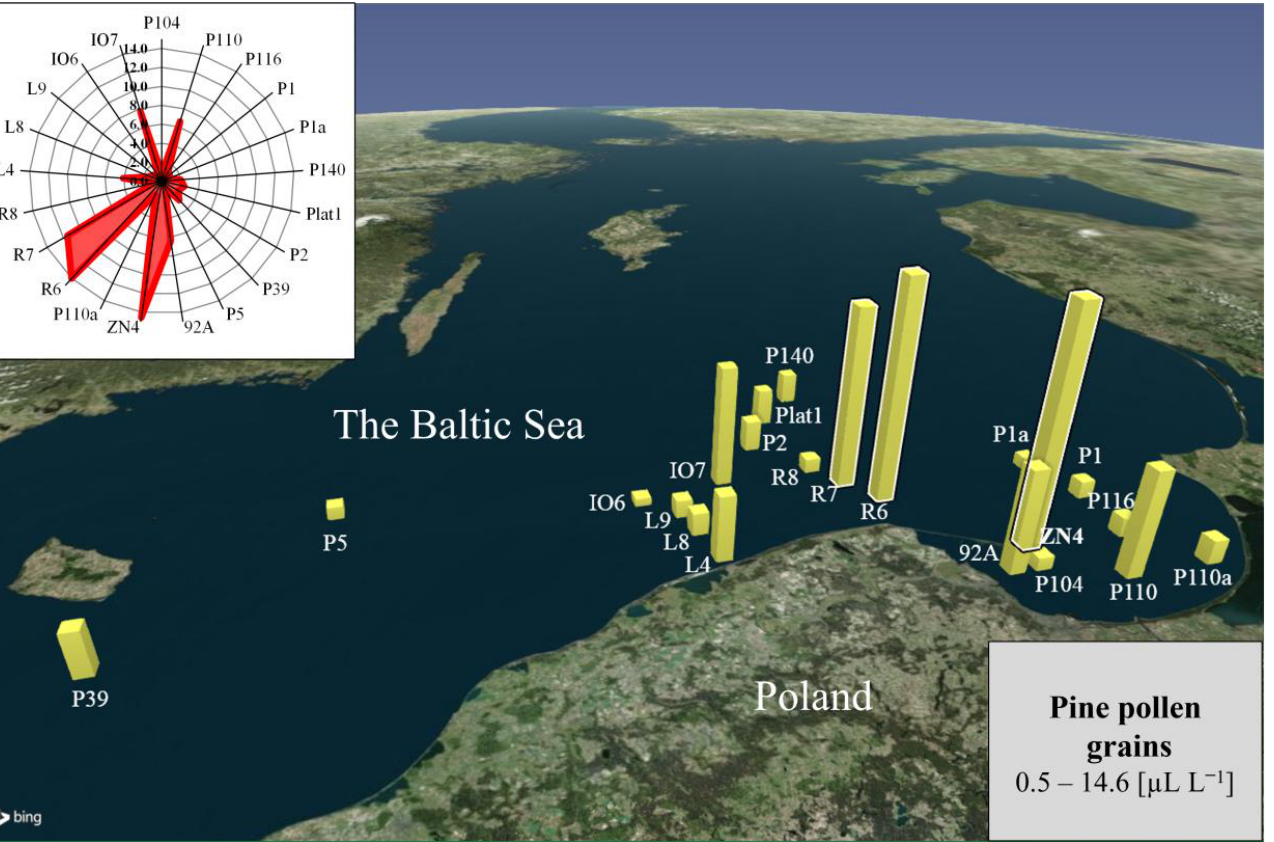
Figure 3. Spatial distribution of concentration of pine pollen grains in May 2018 in (µL L −1 ). Spatially, the pollen concentrations varied very widely: they could be very high or low even at stations quite close to each other. For example, at the open sea stations R7 and R8, ca. 10 km apart, the respective concentrations were 11.49 µ L L − 1 and 0.98 µ L L − 1 , while at stations 92a and P104, ca. 7.8 km apart in the Gulf of Gda´nsk, the respective concentrations were 6.4 µ L L − 1 and 0.8 µ L L − 1